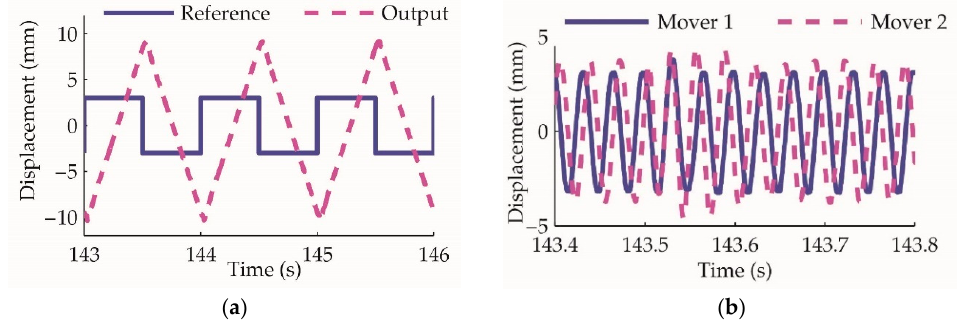
Figure 15. The actuator open-loop control experiment: ( a ) the actuator cylinder position reference and output; ( b ) displacement of the two movers, at approximately 143.55 s, mover Ⅱ phase varies from π /2 to −π /2, and the actuator cylinder is driven reversely.